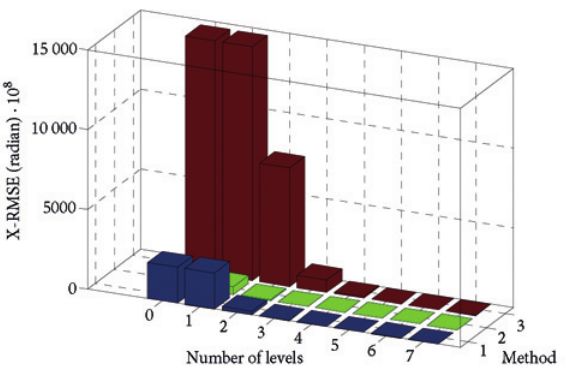
Fig. 14.RMSE (Longitude) changing by increasing termination criterion (a)